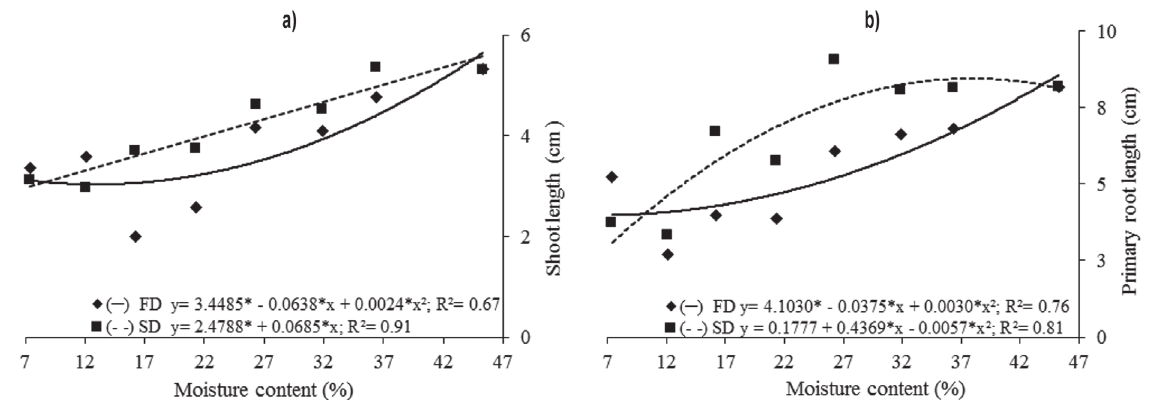
Figure 3 - Effect of drying rate on shoot length (cm) (a) and primary root length (cm) (b) of Campomanesia adamantium seedlings subjected to fast drying (FD) (silica) and slow drying (SD) (room temperature) at different water contents.